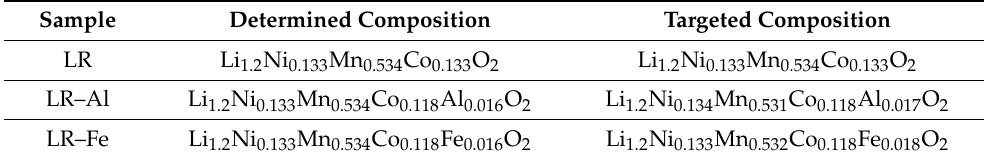
Table 1. ICP-OES analysis